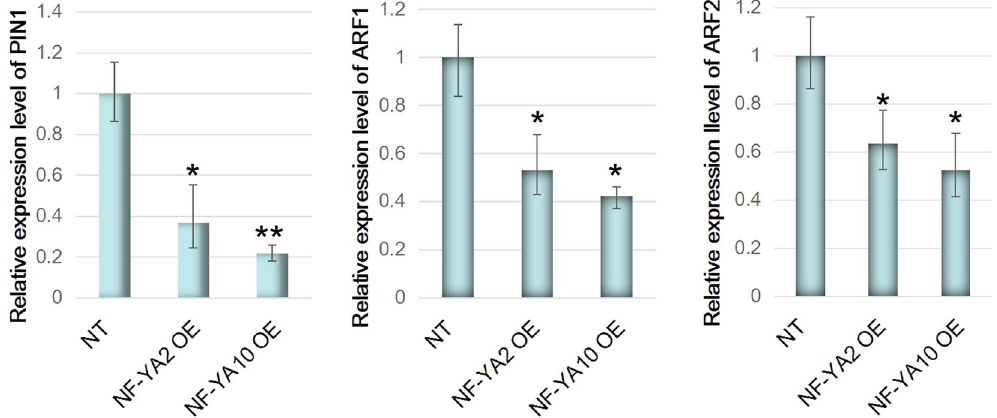
Figure 8. Relative expression levels of PIN1 , ARF1 and ARF2 in NF-YA2 OE and NF-YA10 OE plants.